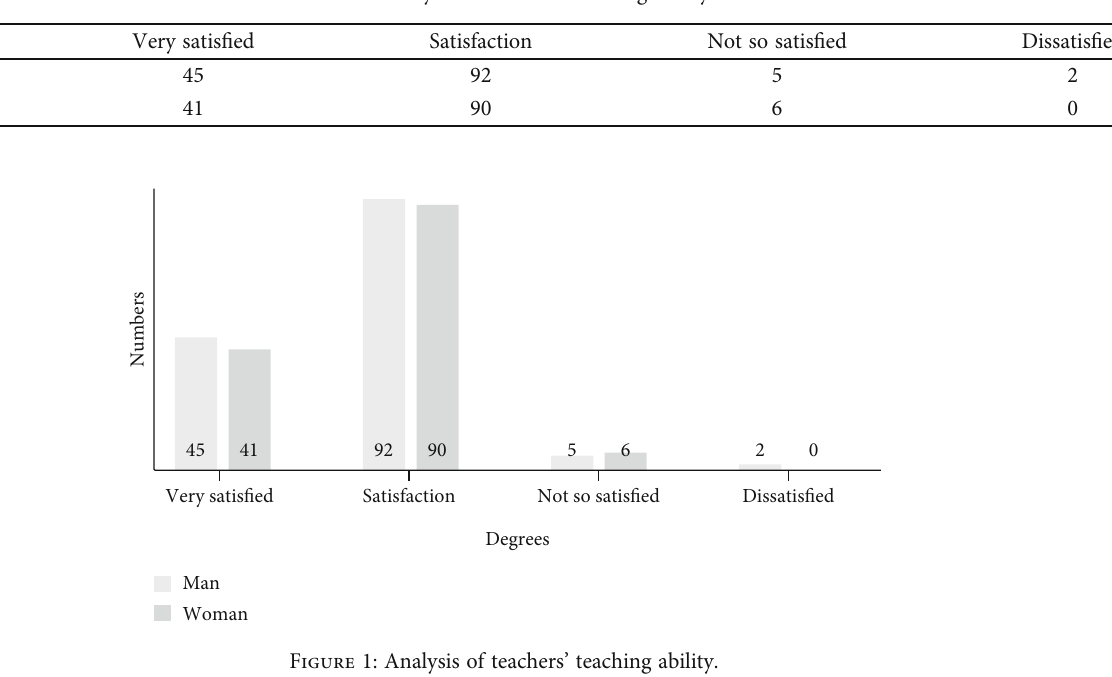
Table description: the id number of the id course is unique. It uses the int type and is the primary key of the table. It cannot be empty. Auto_increment is the realization of automatic growth. Table 2: Analysis of teachers ’ teaching